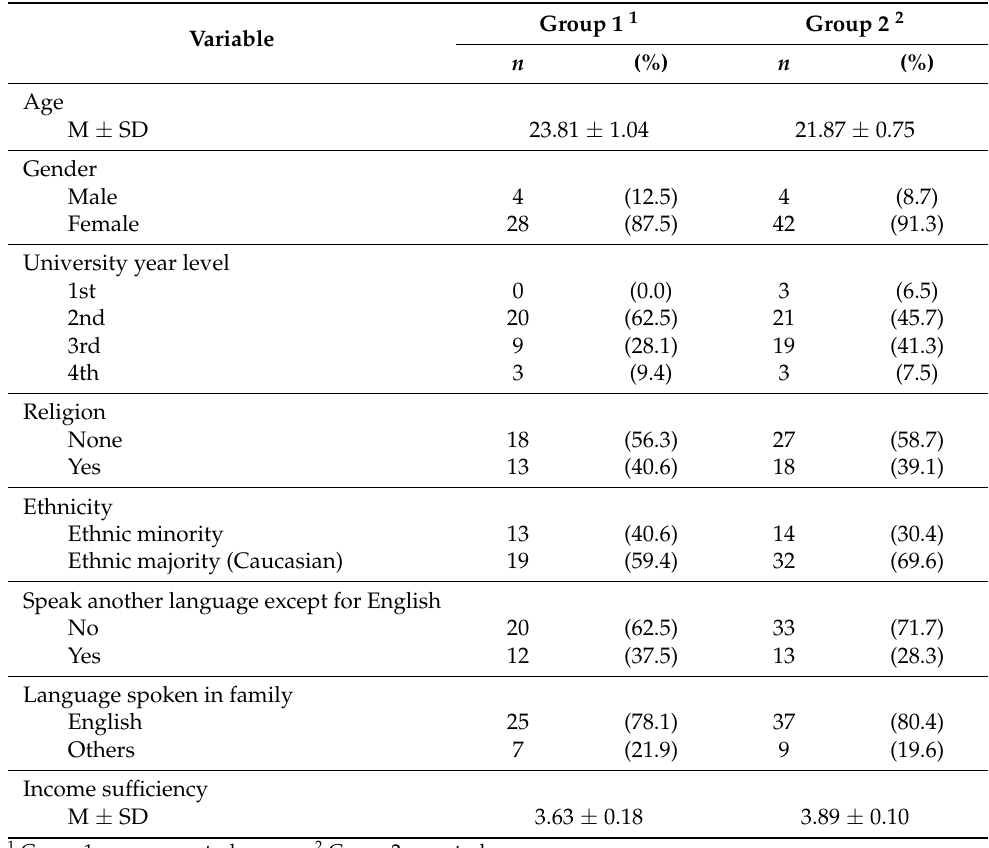
Table 1. Demographic characteristics of the